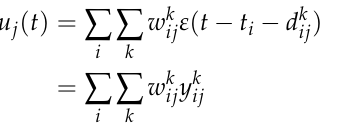
where i is the number of spikes in the pre-synaptic neuron and y k tation of the activation